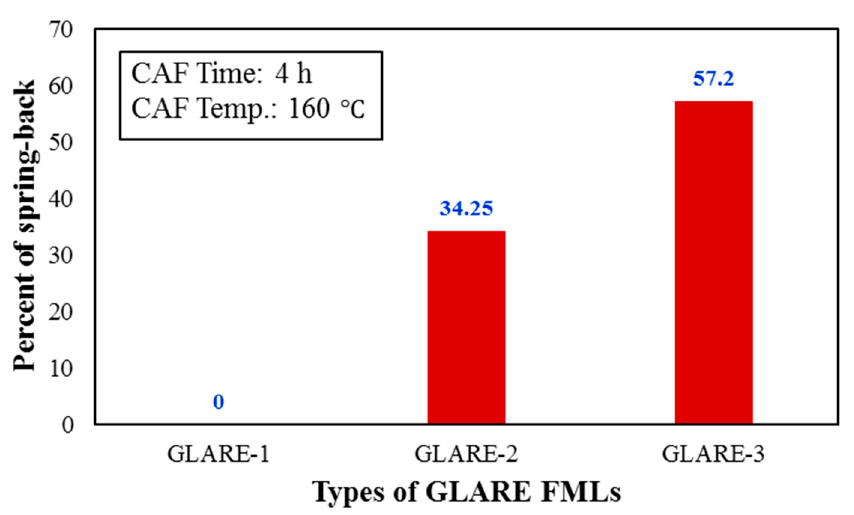
Figure 5. Effect of thickness of composites layer on the springback behavior of GLARE FMLs at CAF time 2 h and temperature 100 °C.